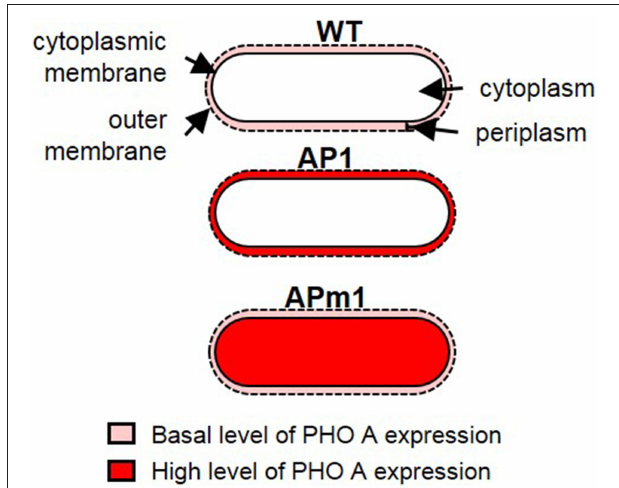
FIGURE 1 | Schematic representation of the different E. coli strains used in the calcification experiments. In WT cells, PHO A is expressed at a basal level and is present in the periplasm. In induced AP1 cells, PHO A is overexpressed and accumulates in the periplasm. In APm1 cells, PHO A is overexpressed and accumulates in the